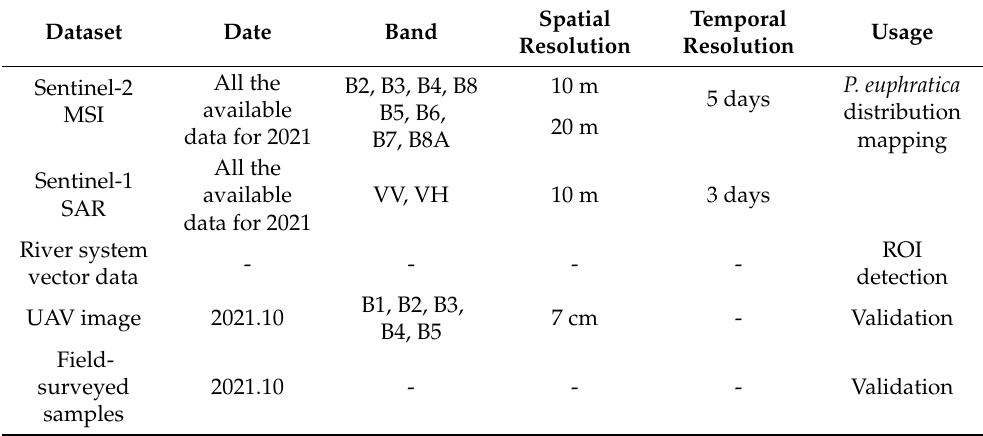
Table 1. Description of